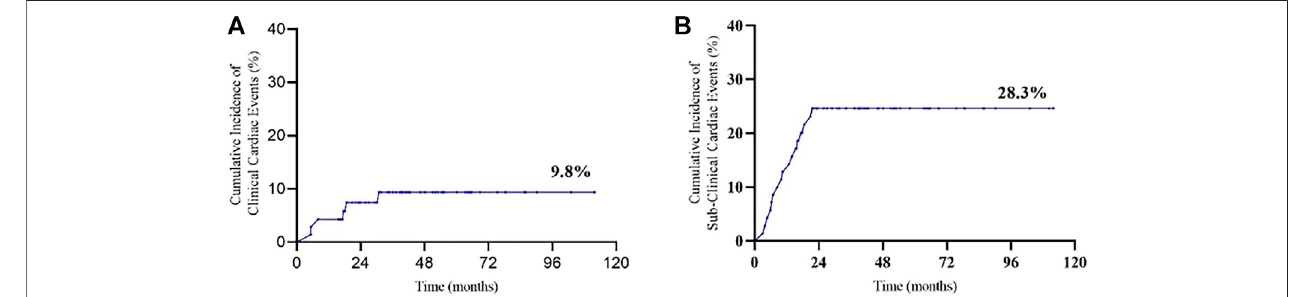
FIGURE 3 | Cumulative incidence of cardiac events: (A) clinical cardiotoxicity and (B) subclinical cardiotoxicity.